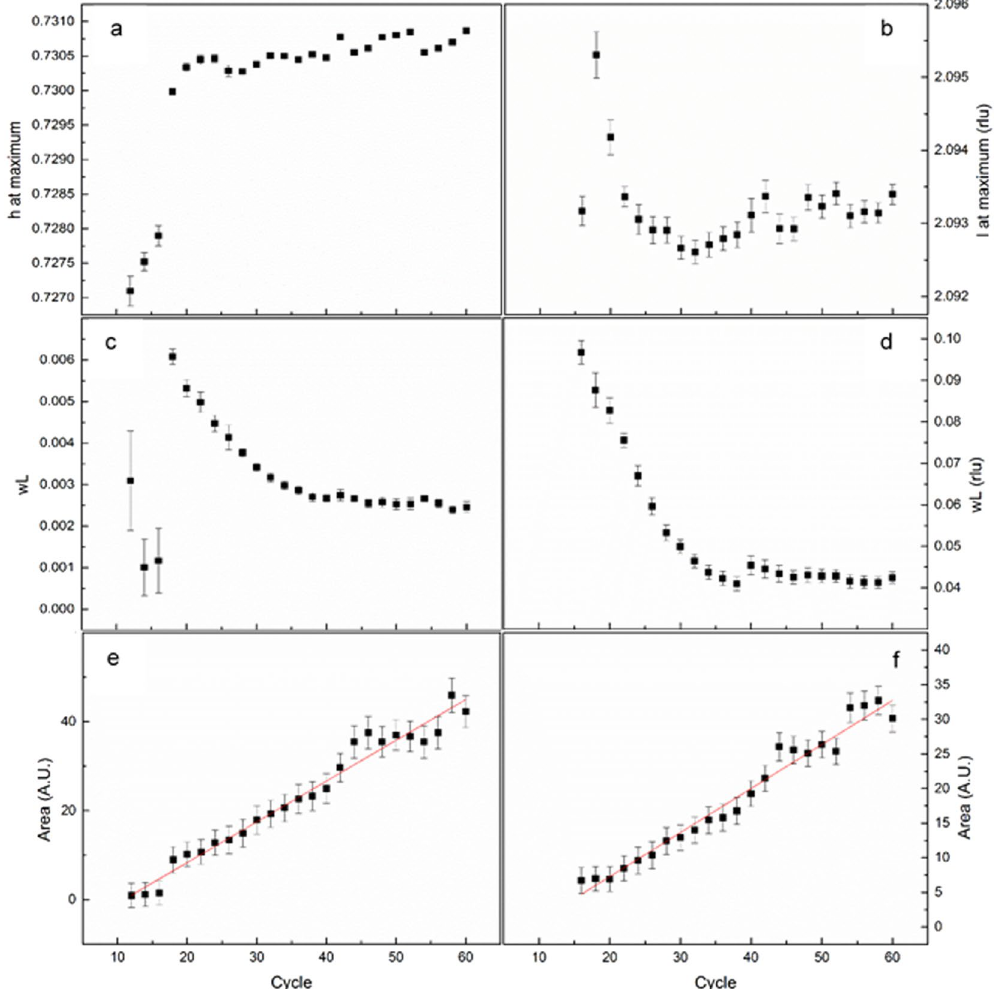
Figure 3. Growth curves for the position at the maximum of the peak, for the Lorentzian breadth (wL) and for the peak area along (h, h, 2.1) ( a,c,e ) and along (0.73, 0.73, l) ( b,d,f ), respectively. The experimental uncertainties are plotted as error bars corresponding to 3 σ .